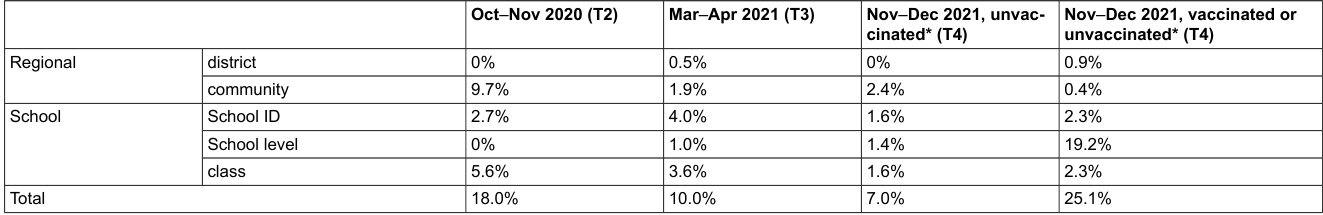
Table S1: Proportion of variance in seroprevalence explained by geographic district, community, school, school level and class, expressed using variance partition coefficient (percent of total variation explained by within cluster variation).